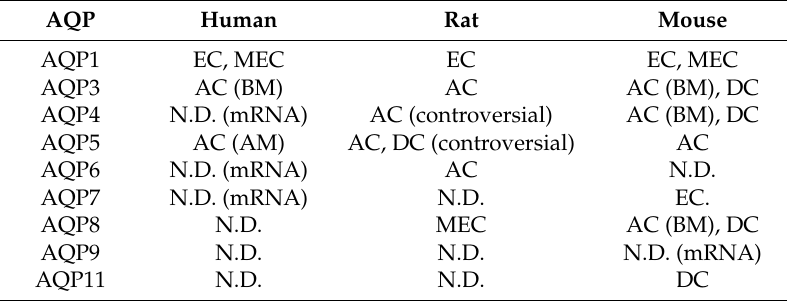
Table 1. Expression and localization of AQPs in salivary